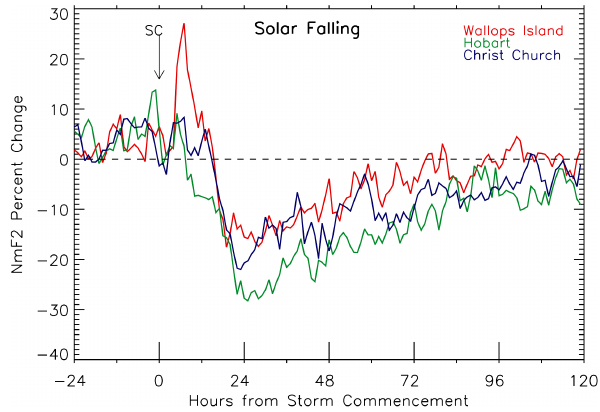
Fig. 13. Comparison of average patterns during solar declining phase at Wallops Island, Hobart and Christchurch stations. Their geomagnetic latitudes are 50.47 ◦ N, 54.05 ◦ S and 50.27 ◦ S, respec-